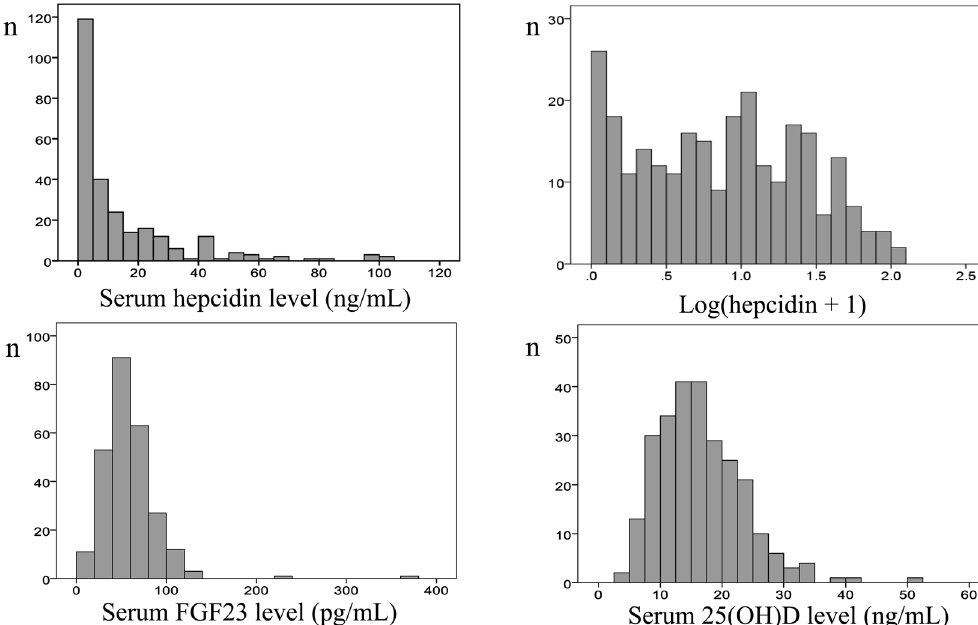
Figure 1. Distributions of serum hepcidin, FGF23, and 25(OH)D levels. As serum hepcidin levels were not normally distributed, the actual hepcidin level + 1 was logarithmically